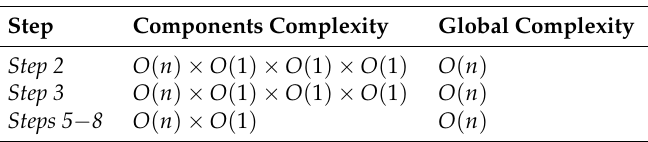
Table 5. LFE computational